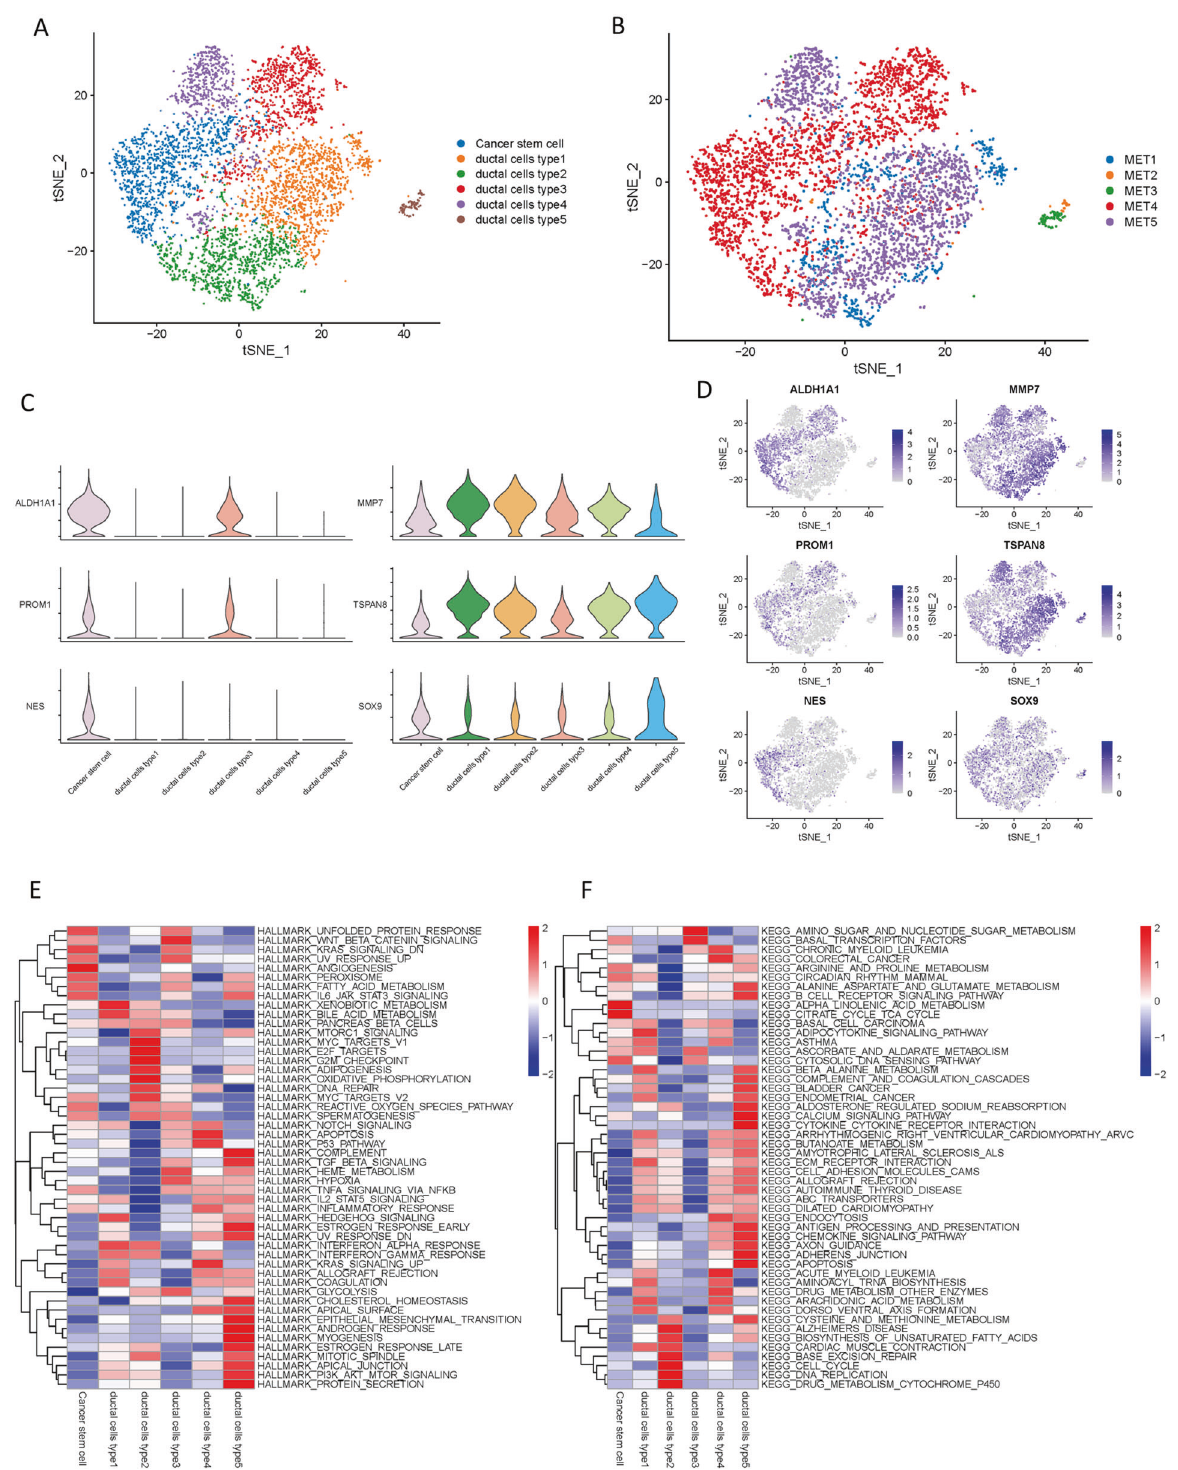
Fig. 3 Distinct clusters of malignant cells in metastatic PDAC lesions. A t-SNE plot showing the 6 malignant cell subclusters from 5 PDAC samples. B Six malignant PDAC cell subclusters were identi fi ed by t-SNE analysis. C Violin plots for marker genes of cancer stem cells (ALDH1A1, PROM1, and NES) and ductal cells (MMP7, TSPAN8, and SOX9). D Feature plots for marker genes of cancer stem cells (ALDH1A1, PROM1, and NES) and ductal cells (MMP7, TSPAN8, and SOX9). The color legend shows the log1p normalized expression levels of the genes. E Heatmap showing the representative pathway terms of Hallmark enriched in each cellular subgroup. F Heatmap showing the representative pathway terms of KEGG enriched in each cellular subgroup.